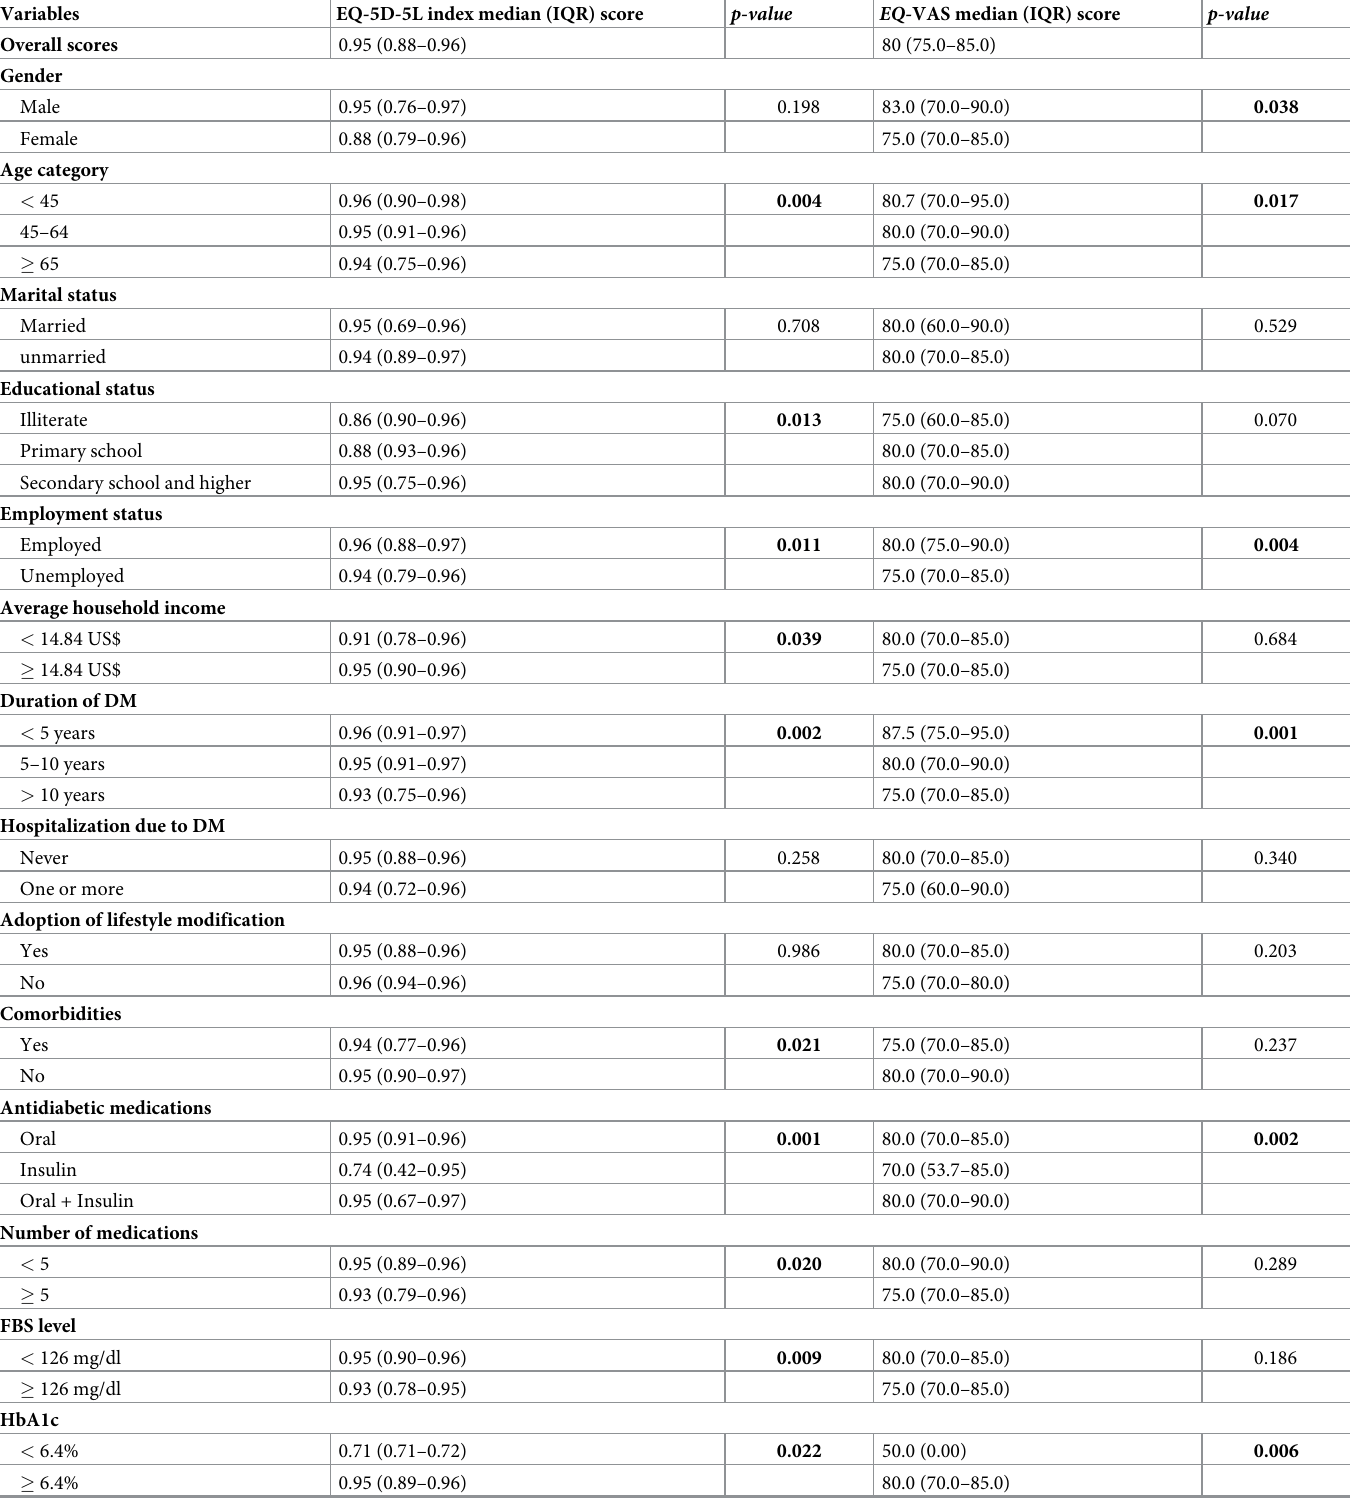
Table 3. Median (IQR) differences of EQ-5D-5L utility and EQ-VAS scores with patient demographic and clinical